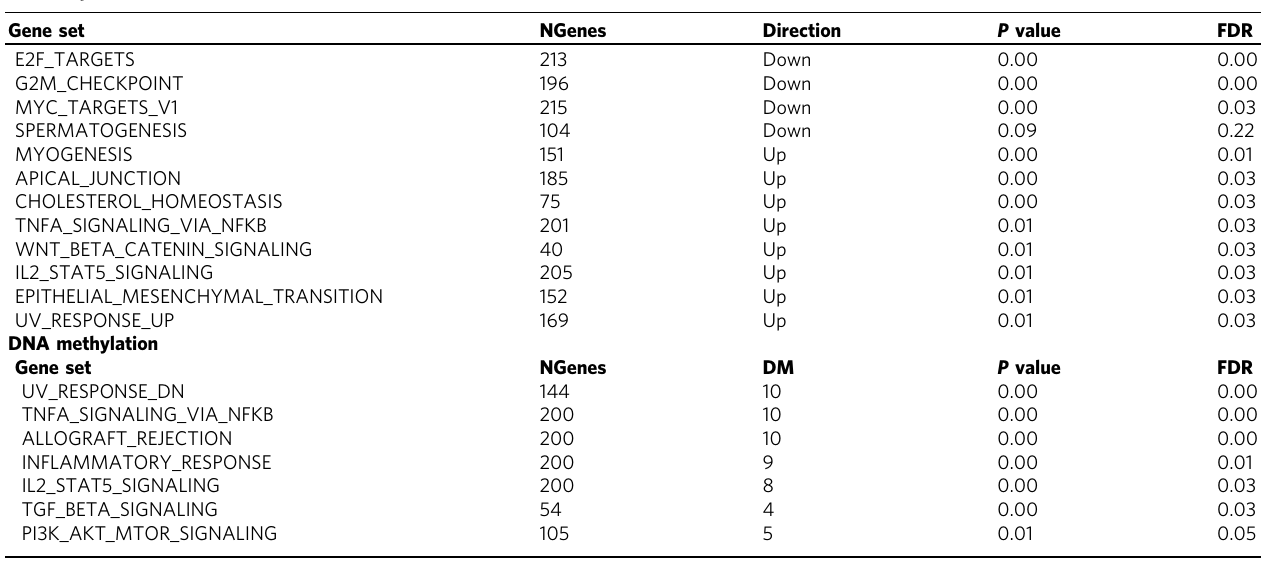
Table 2 Gene sets analysis of differentially expressed and methylated genes in allergics vs. controls at baseline RNA-seq Gene set